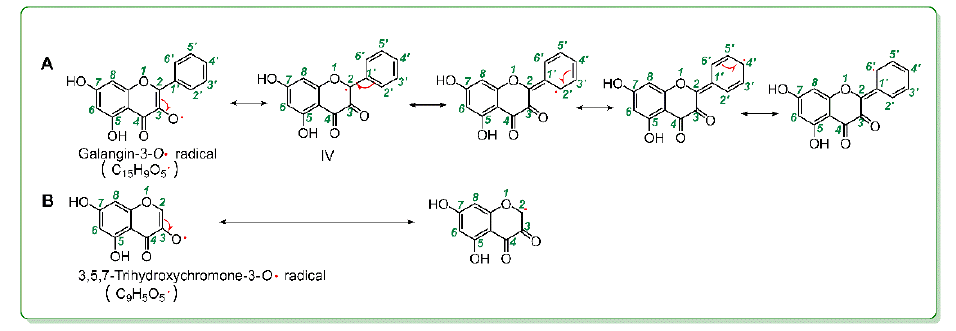
Figure 7. Resonance formula of the galangin-3- O • radical (C 15 H 9 O 5 • , A ) and the